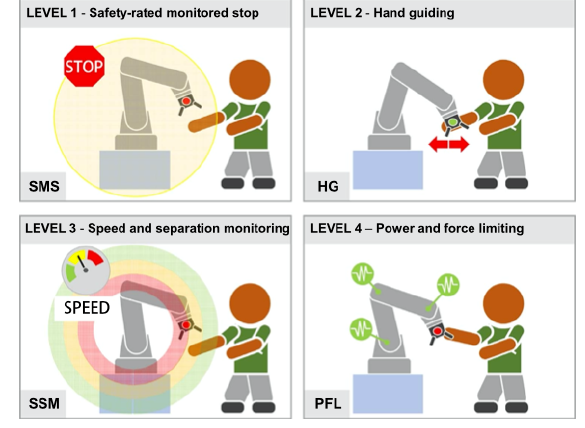
Figure 2. Robot collaborative modes (ISO